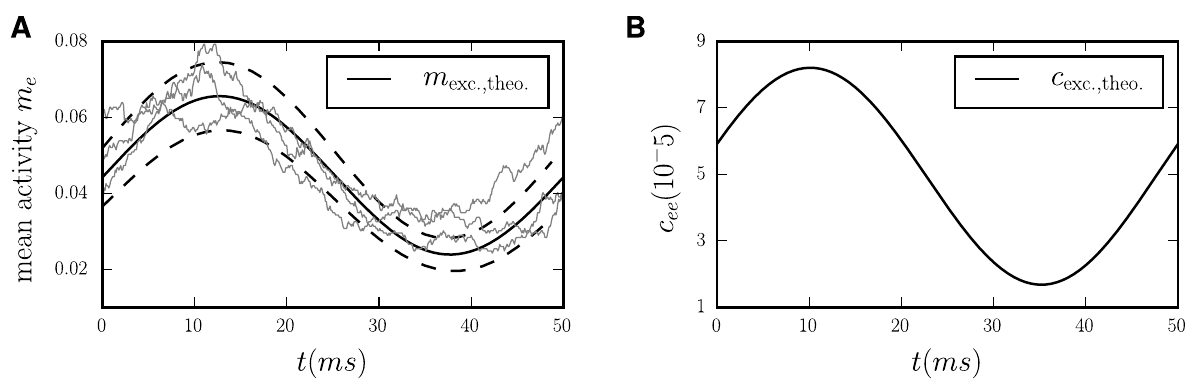
P ð t Þ ¼ N (cid:0) 1 ð t Þ in a balanced EI-network (parameters given in n E i E i 2 E þ c (Eqs (3) and (4)). B EE N E EE